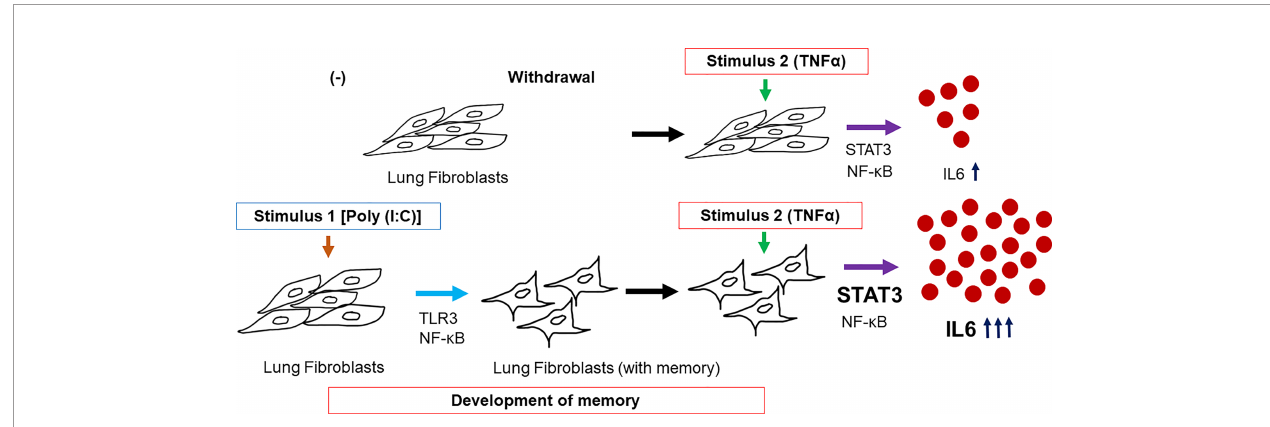
FIGURE 8 | Model summarizing the possible mechanism in the development of in fl ammatory memory in human lung fi broblast as exhibited by increased IL6 response. Pretreatment with Poly (I:C)-activated TLR3 and NF- k B pathways and responses were stored by the lung fi broblasts. Upon secondary treatment of the cells with memory, STAT3 and NF- k B were simultaneously activated further increasing IL6